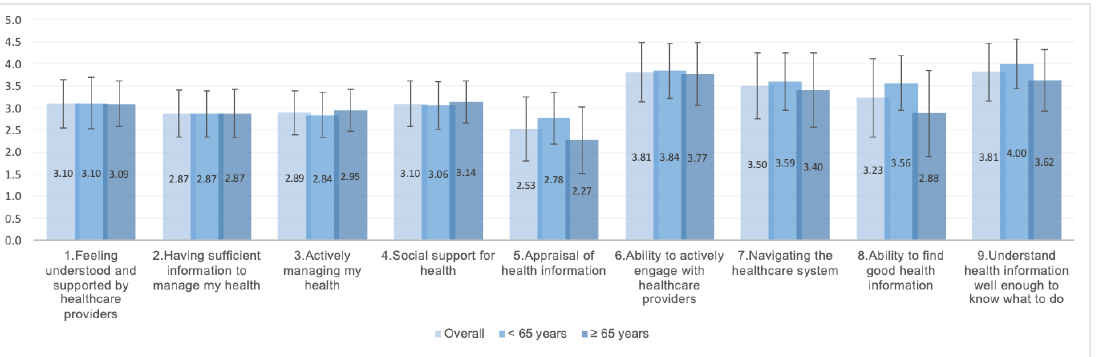
Figure 1. HLQ dimension scores for the study population as a whole and by age group ( ≤ 65 and >65 years). Mean and standard deviation for responses to the Health Literacy Questionnaire (HLQ). Dimensions 1–5 were scored on a scale of 1–4, and dimensions 6–9 on a scale of 1–5. Higher score, better health